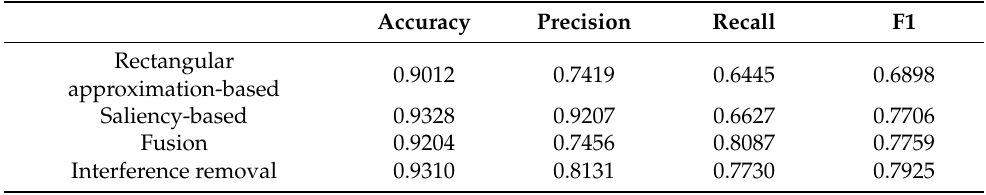
Table 3. Image I detection